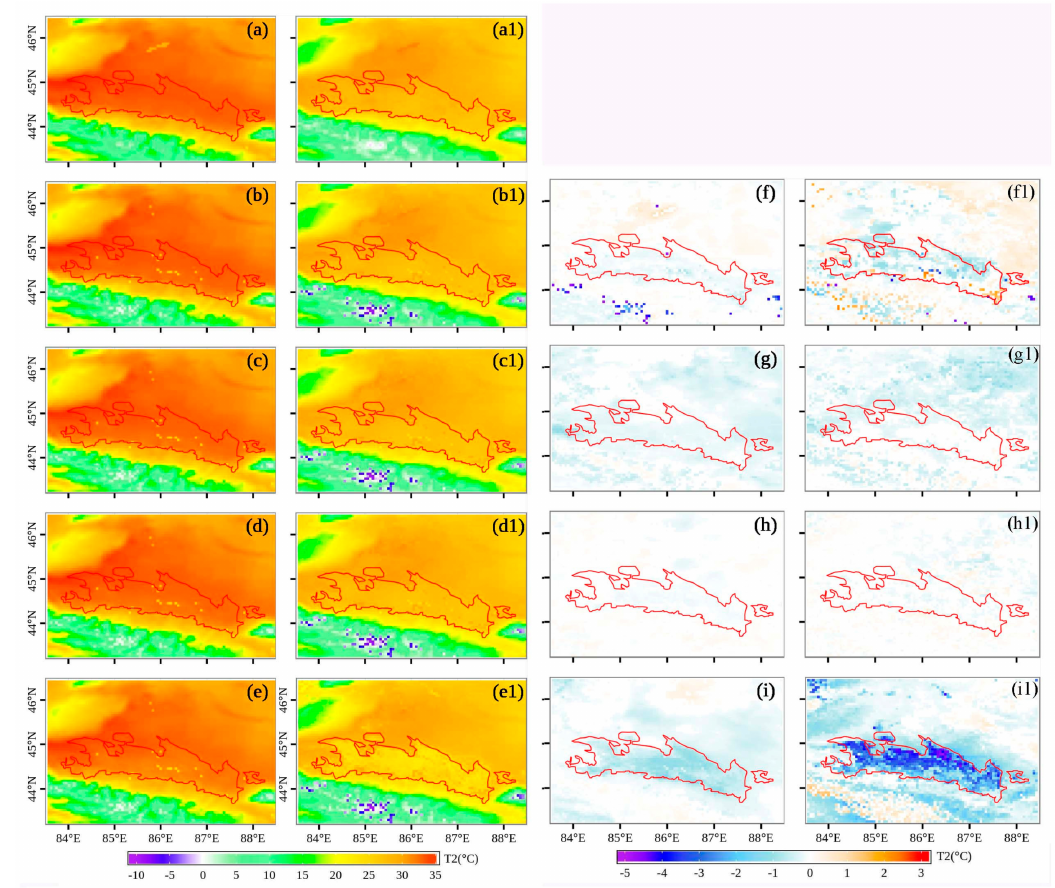
Figure 8. Daytime spatial patterns of 2 m air temperature (T2) from the ( a ) def, ( b ) LU, ( c ) Alb, ( d ) LAI and ( e ) VF simulations, and their differences ( f ) b–a , ( g ) c–b , ( h ) d–c and ( i ) e–d (these difference pixels are statistically significant at p < 0.05). And corresponding patterns during the night-time, which are labelled with the corresponding daytime label and the number 1. The def simulation used default LU, albedo, LAI, and VF provided by WRF itself; the LU simulation used only actual LU data; the Alb simulation used only actual LU and albedo data; the LAI simulation used actual LU, albedo, and LAI data, and the VF simulation used all of the actual terrestrial datasets. The red line represents the border of the key oasis